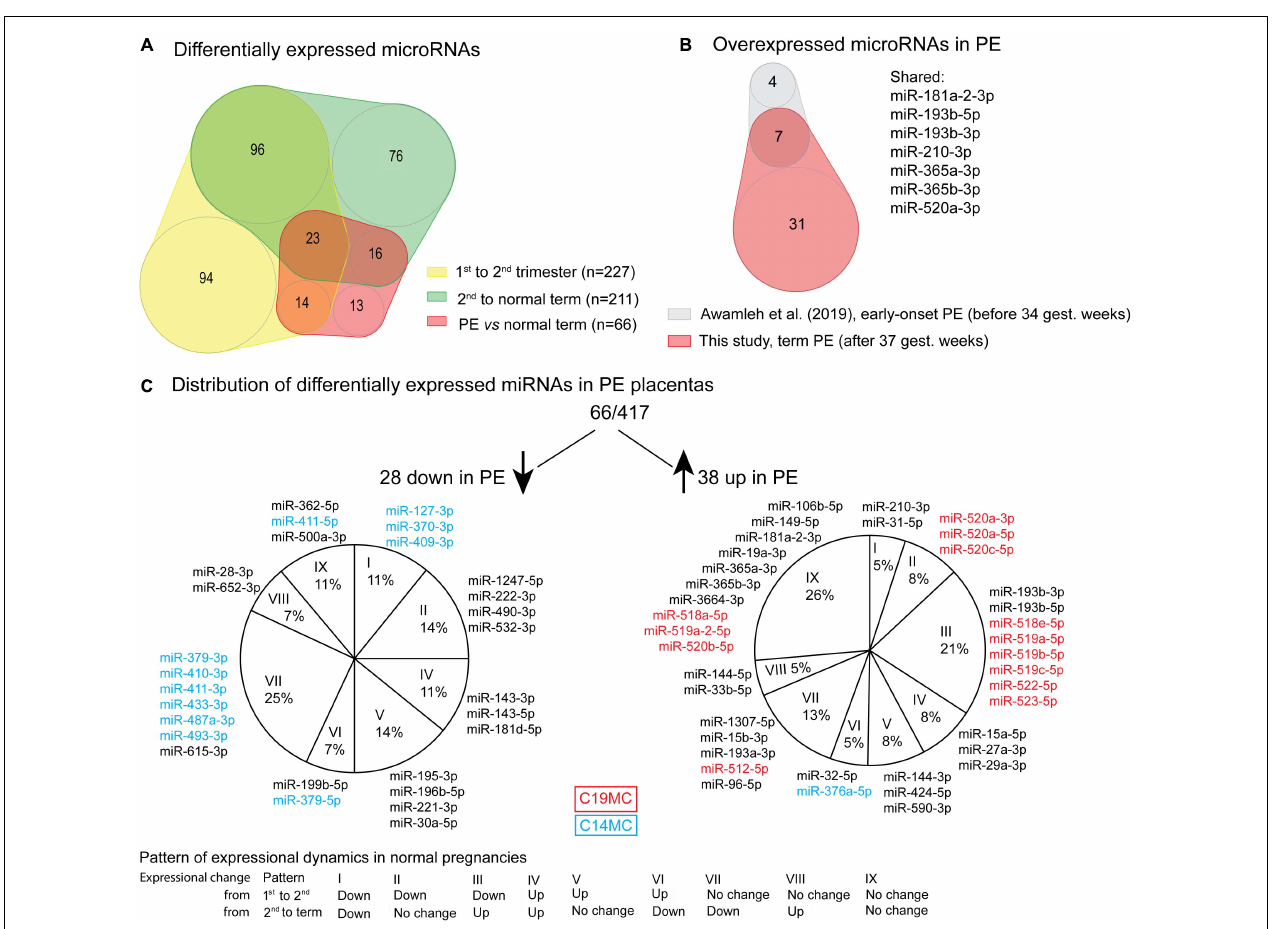
FIGURE 2 | Differentially expressed miRNAs in preeclampsia (PE). (A) Overlap of differentially expressed miRNAs in PE ( Supplementary Table 21 ) with miRNAs showing gestational dynamics ( Supplementary Tables 8 , 9 ). (B) Significantly upregulated miRNAs overlapping between term PE placentas in the current study and early-onset PE placentas in miR-Seq study by Awamleh et al. (2019). (C) Distribution of differentially expressed miRNAs in PE placentas according to their gestational dynamics patterns ( Table 2B ). miRNAs transcribed from placental-specific C14MC and C19MC clusters are highlighted in blue and red color,